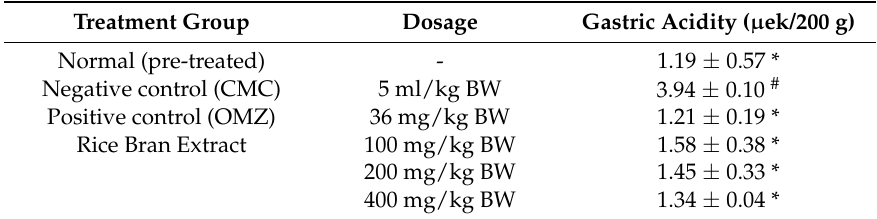
Table 2. The effect of rice bran extract on gastric acidity induced by